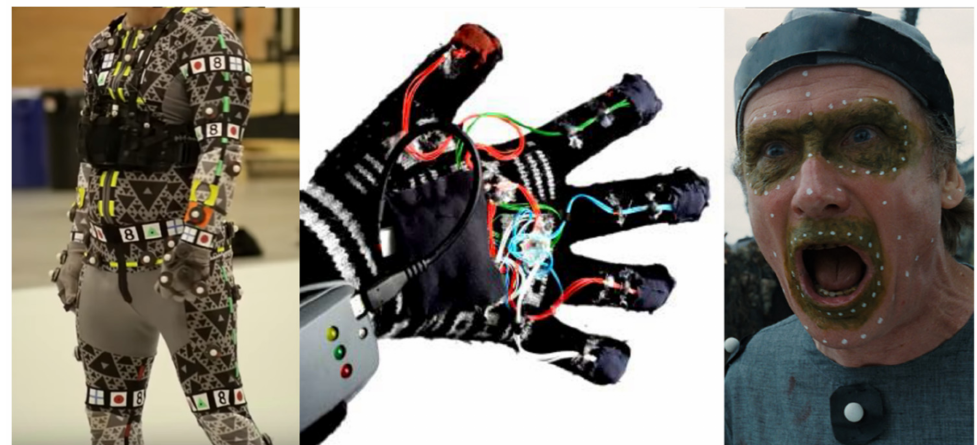
Figure 5. Motion capture suit [31], data glove [32] and markers for facial tracking [33].